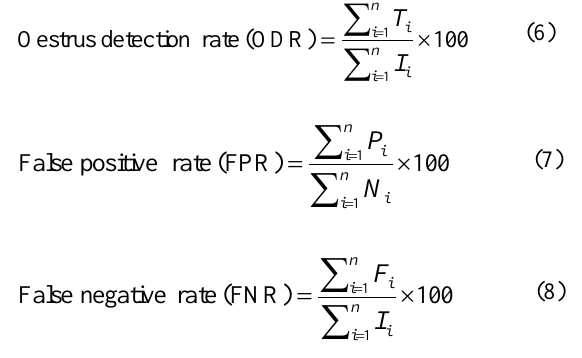
Table 1. Performance of the proposed system in oestrus sound detection No.